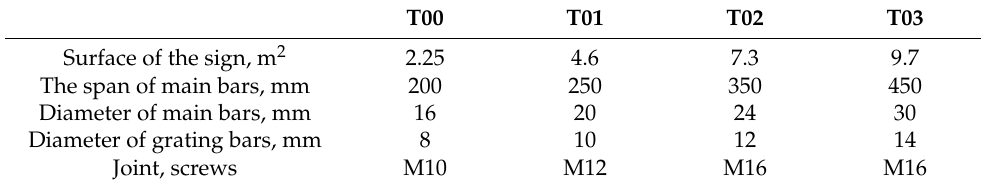
Table 3. Main geometric properties of